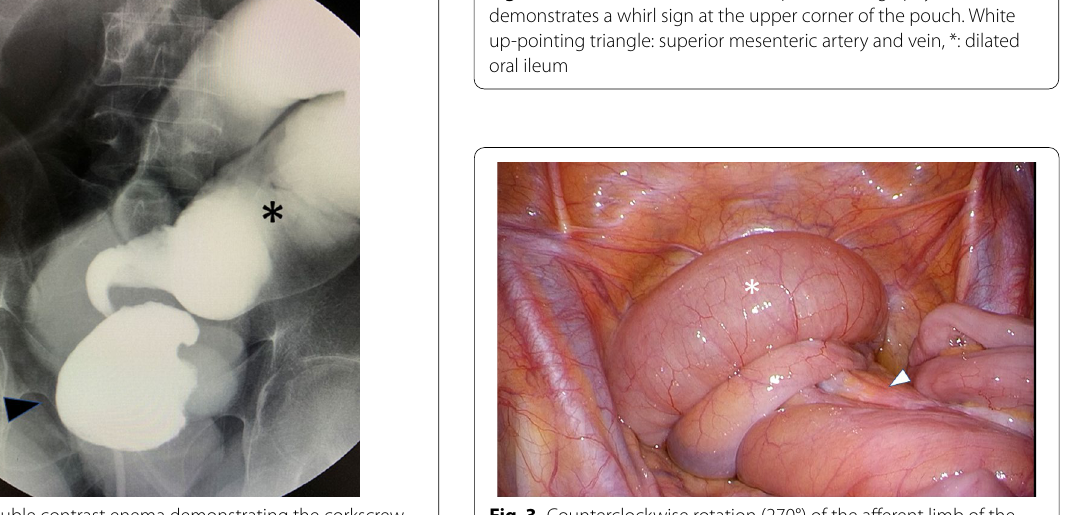
Fig. 1 Water-soluble contrast enema demonstrating the corkscrew configuration of the afferent limb of the pouch and dilation of the oral ileum. Black up-pointing triangle: J-pouch, *: dilated oral ileum